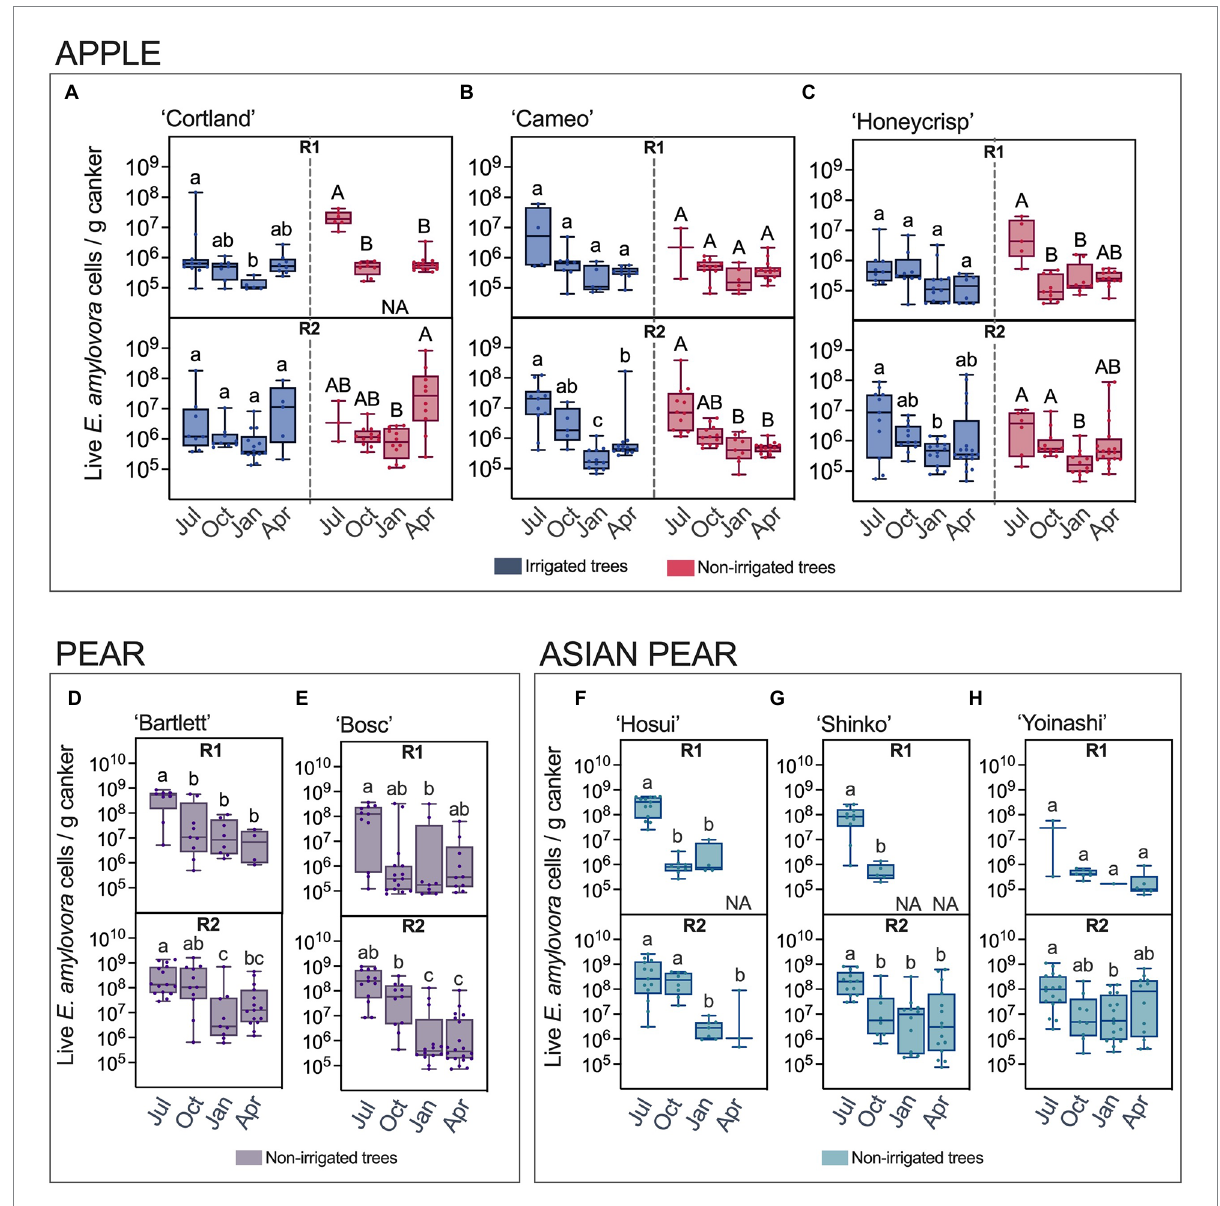
FIGURE 3 Live E. amylovora cell concentrations in cankers on irrigated and non-irrigated apple trees of the cultivars ‘Cortland’ (A) , ‘Cameo’ (B) and ‘Honeycrisp’ (C) , non-irrigated pear trees ‘Bartlett’ (D) and ‘Bosc’ (E) , and non-irrigated Asian pear trees ‘Hosui’ (F) , ‘Shinko’ (G) and ‘Yoinashi’ (H) . The median, first and third quartiles and the data range are indicated with box and whisker plots. Only cankers positive for E. amylovora detection were used in this analysis. Dots are E. amylovora concentrations in individual cankers. NA (not applicable) indicates that no positive detections were recorded in the specified cultivar/time point/experiment repeat. Different letters denote statistically significant differences ( p < 0.05) between the E. amylovora concentrations in cankers collected in July (Jul), October (Oct), January (Jan), and April (Apr) assessed by Dunn’s multiple comparisons tests after Kruskal-Wallis ANOVA on ranks. In apple samples, lowercase and capital letters differentiate comparisons using data from irrigated and non-irrigated trees, respectively. Pairwise comparisons between the E. amylovora concentrations in cankers from irrigated and